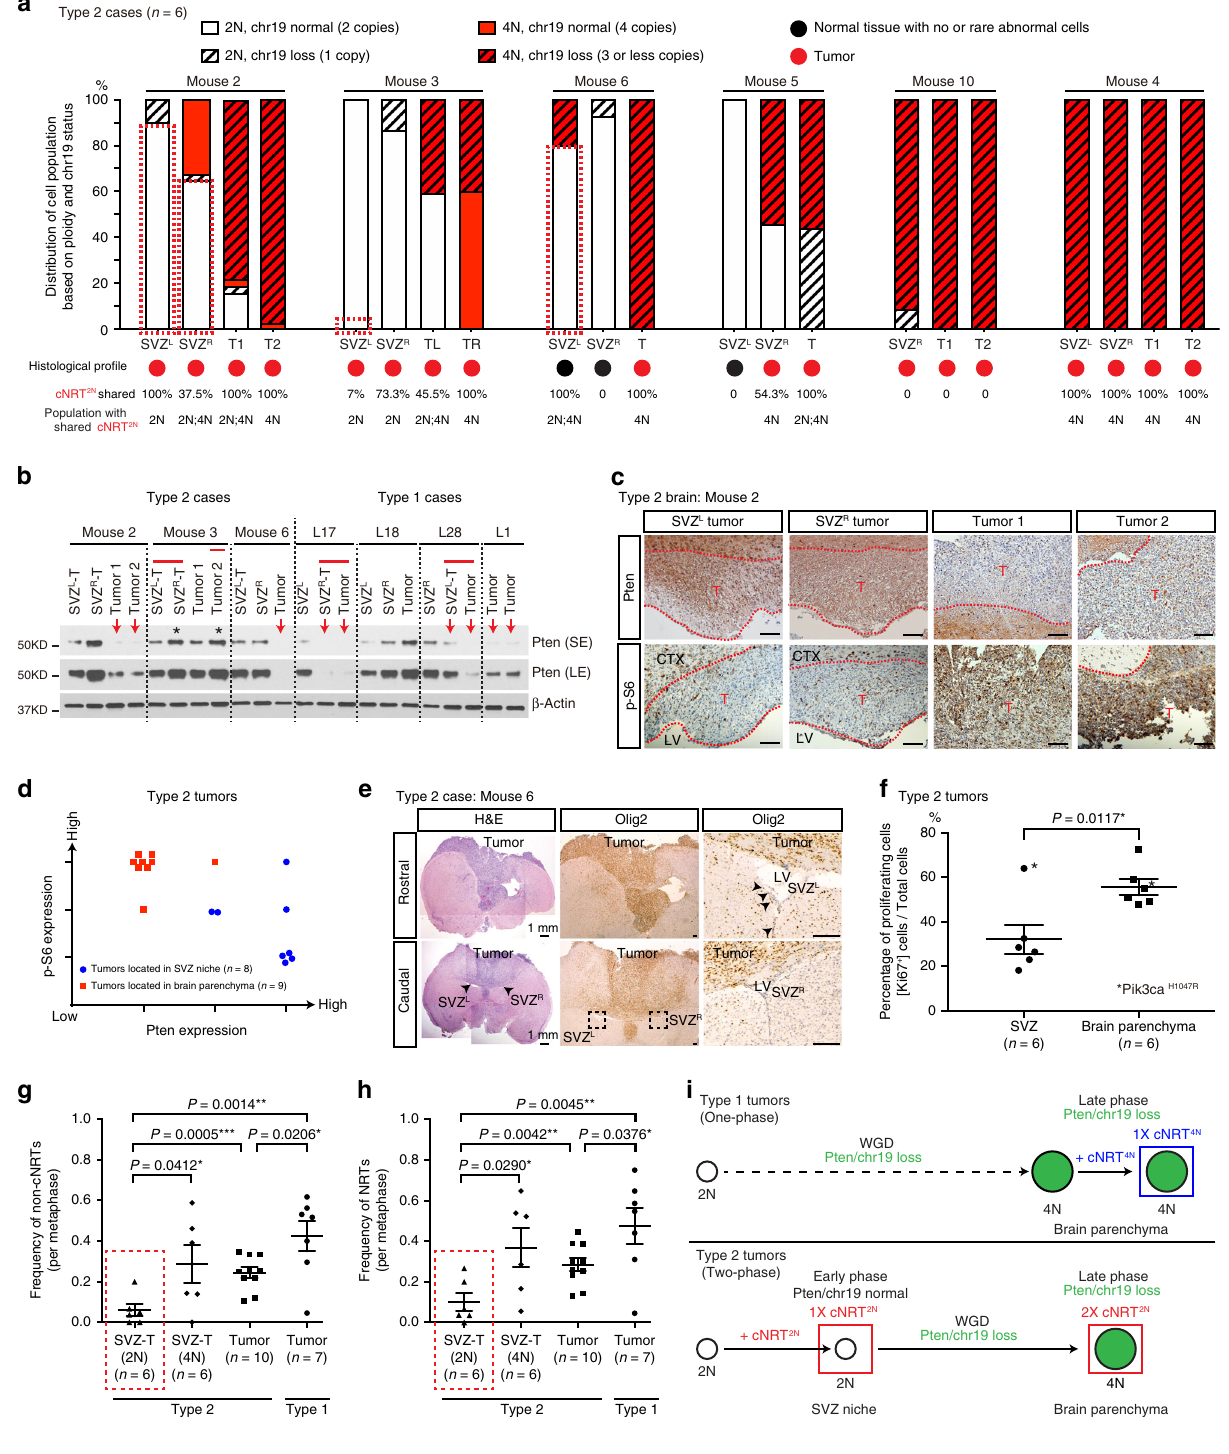
fe Olig2Type 2 case: Mouse 6